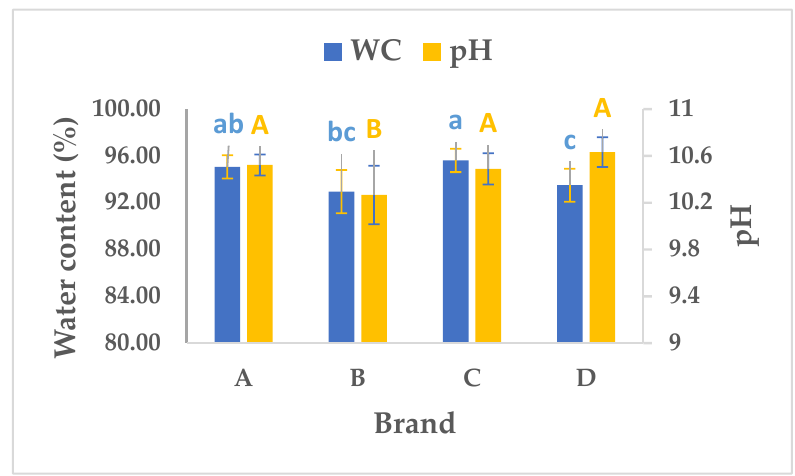
Figure 1. Water content (WC) and pH values of the four lutefisk brands. Reproduced in compliance with CC BY license from Ref. [24].